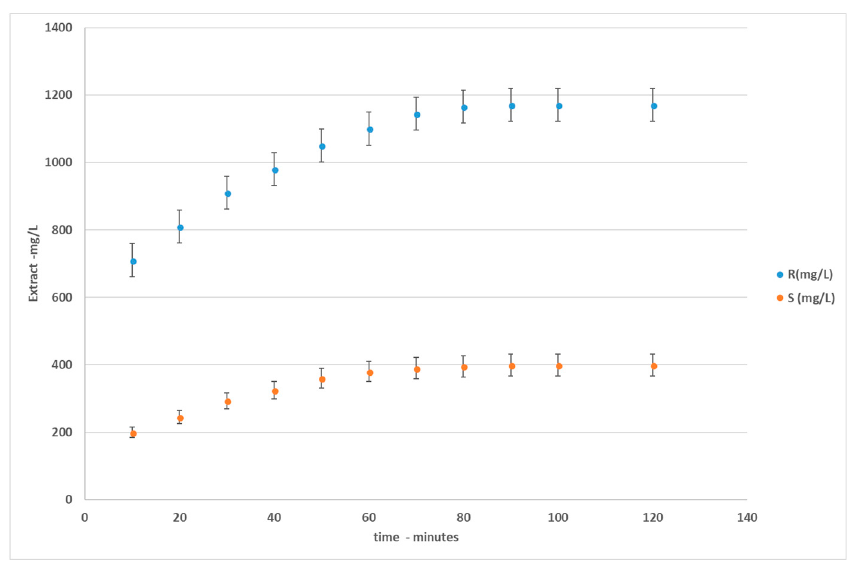
Figure 3. Diagram of the kinetics of cold extraction in the Naviglio extractor (with error bars) of rebaudioside A (blue, above) and stevioside (orange, under).